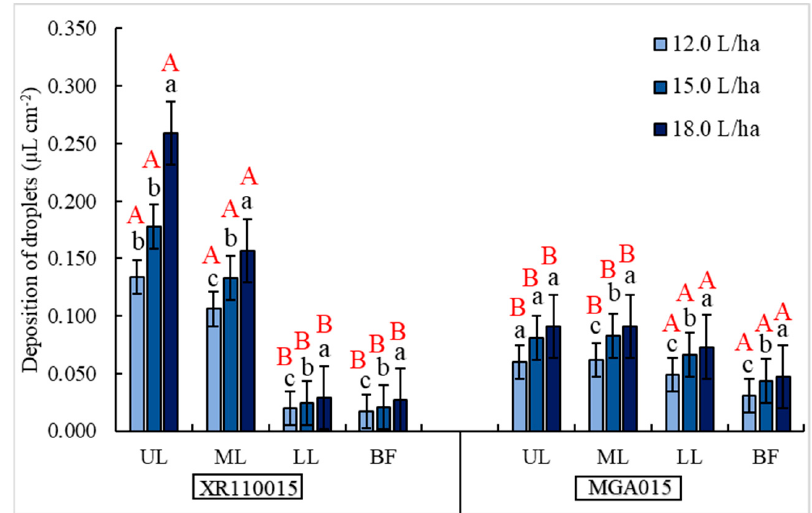
Figure 7. Droplet deposition ( µ L cm − 2 ) in the different collection positions: upper layer (UL), middle layer (ML), lower layer (LL), and bunch of fruit (BF) of the papaya tree. Distinct letters: lower case differ between the application rates and upper case differ between the spray nozzles in the respective collection layers, Tukey’s test at p ≤ 0.05.